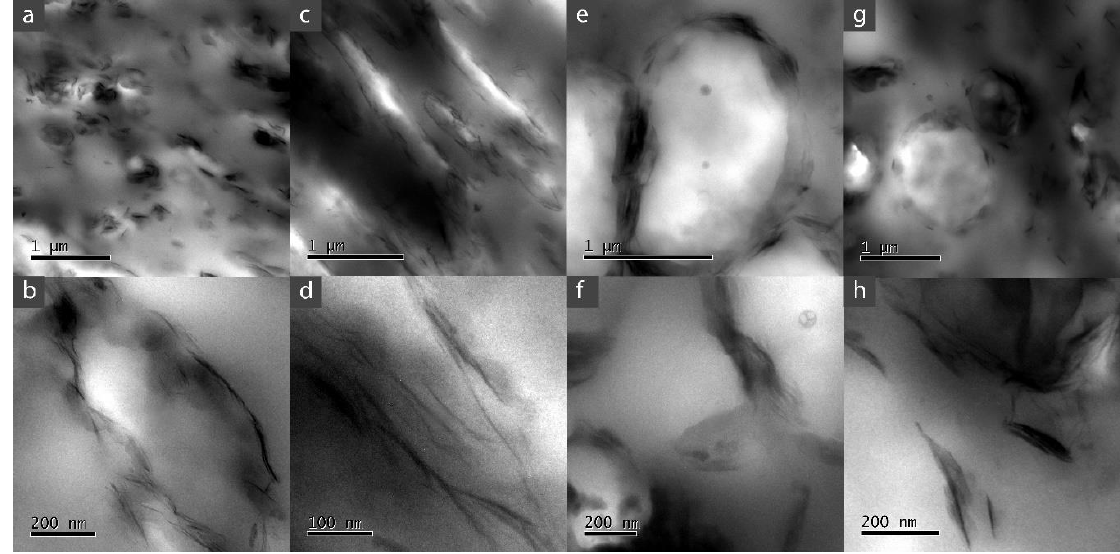
Figure 2. TEM images for the polymeric blends and the nanocomposites. ( a , b ) PP/EVA12/MMT, ( c , d ) PP/EVA28/MMT, ( e , f ) PP/EVOH38/MMT and ( g , h ) PP/EVOH44/MMT.